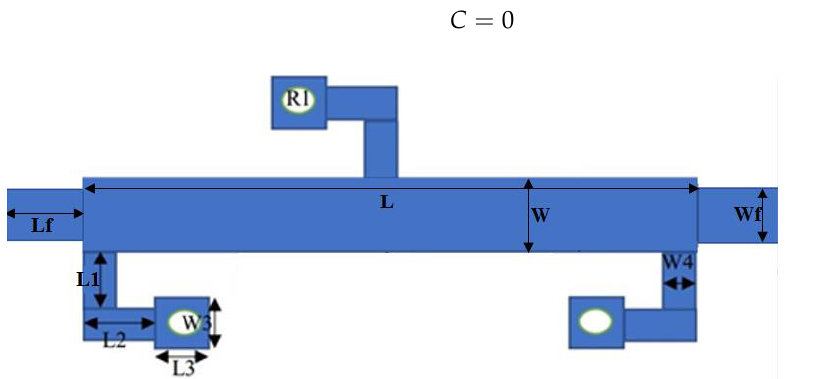
Figure 2. Proposed SUWB-BPF architecture.